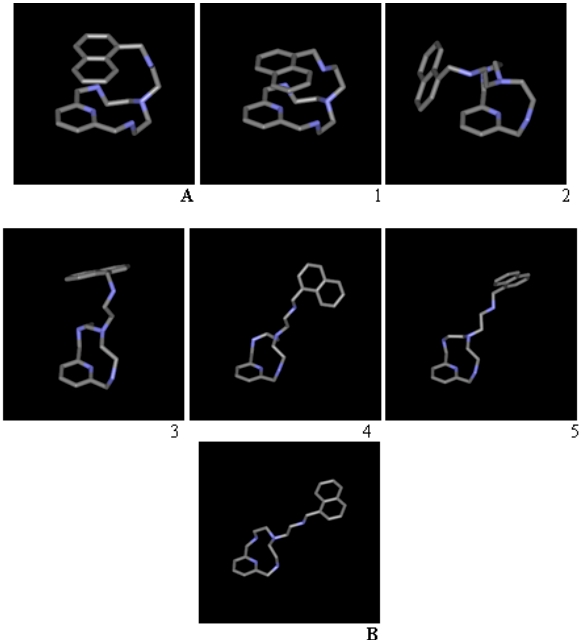
Figure 4. ( A , B ) Conformations from X-ray minimized in the periodic box. 1 – 5 , conformations obtained from MCMM in vacuum and further minimization in standard water density-constant TI3P box until their respective local minima, for different runs.